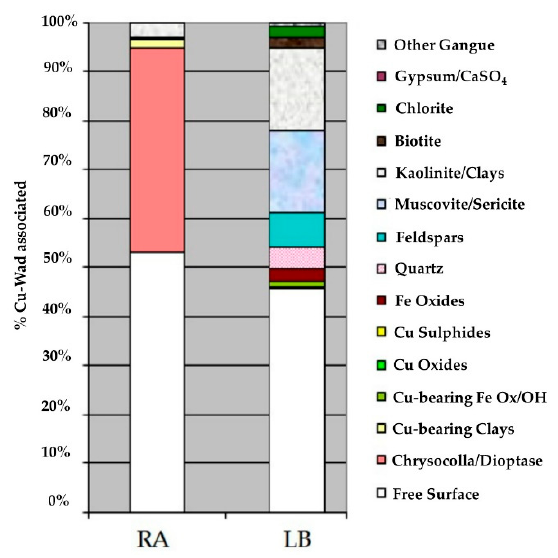
Figure 5. Cu wad associated in samples RA and LB.